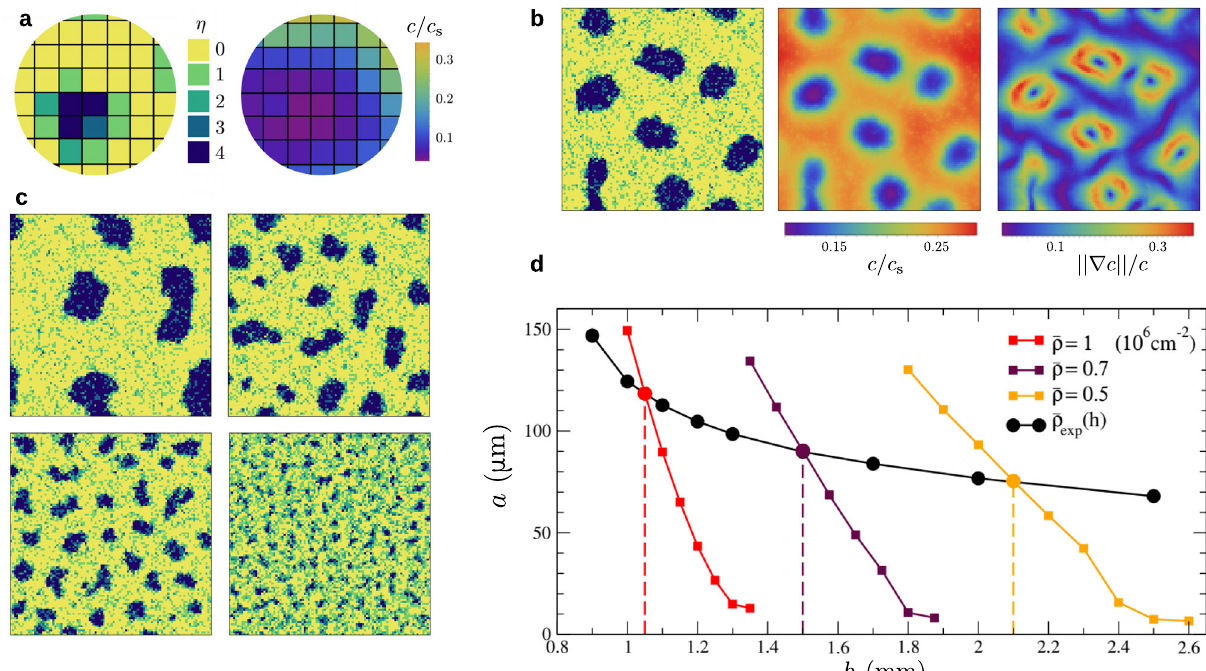
Fig. 4 | Cell-based simulations provide a microscopic view of microphase separation. a Schematic of the two-dimensional lattice model. Each site is occu- piedbyanumber η ofcells,withmaximum η max =4.Theoxygenconcentration fi eld is assumed steady. Cells adhere to their neighbors, consume oxygen and become aerotacticatlowconcentrationwhen c / c s < c aer =0.1. b Exampleofaggregate.From left to right, occupation number, oxygen concentration and term ∣∣ ∇ c ∣∣ / c control- ling aerotaxis. The cell density is (cid:1) ρ = 10 6 cm − 2 , the height h =1.1mm and the lattice